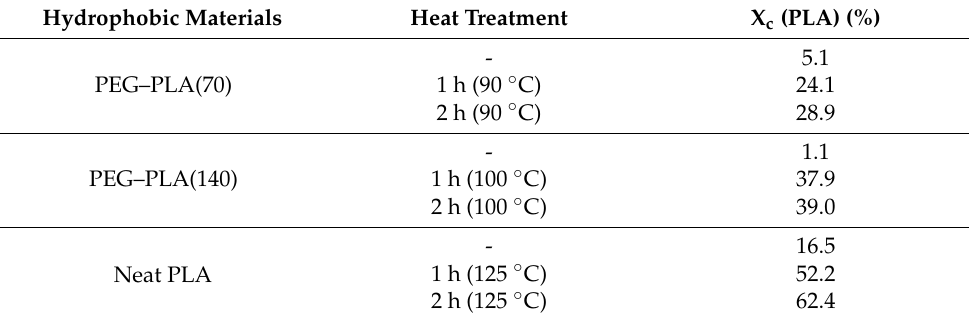
Table 4. PLA crystallinities of heat-treated hydrophobic materials.